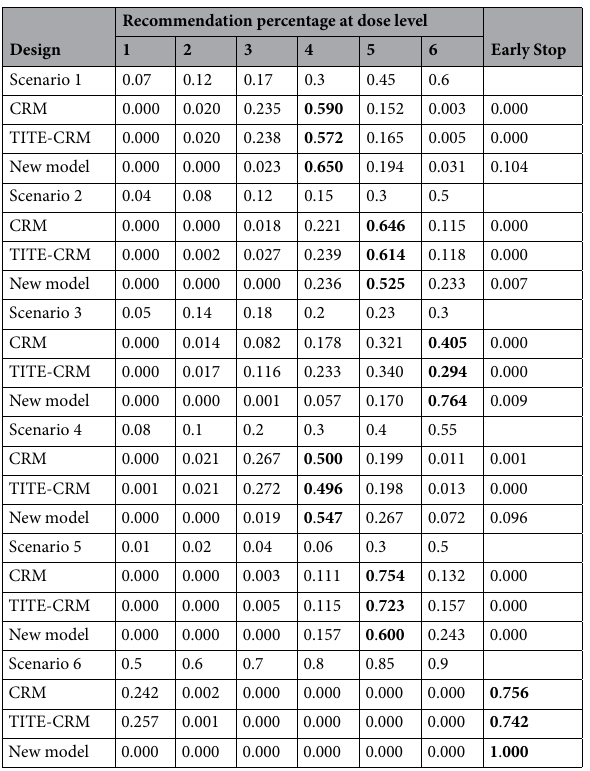
Table 4. Simulation study comparing the results of CRM, TITE-CRM and the new model. Results at MTDs are in